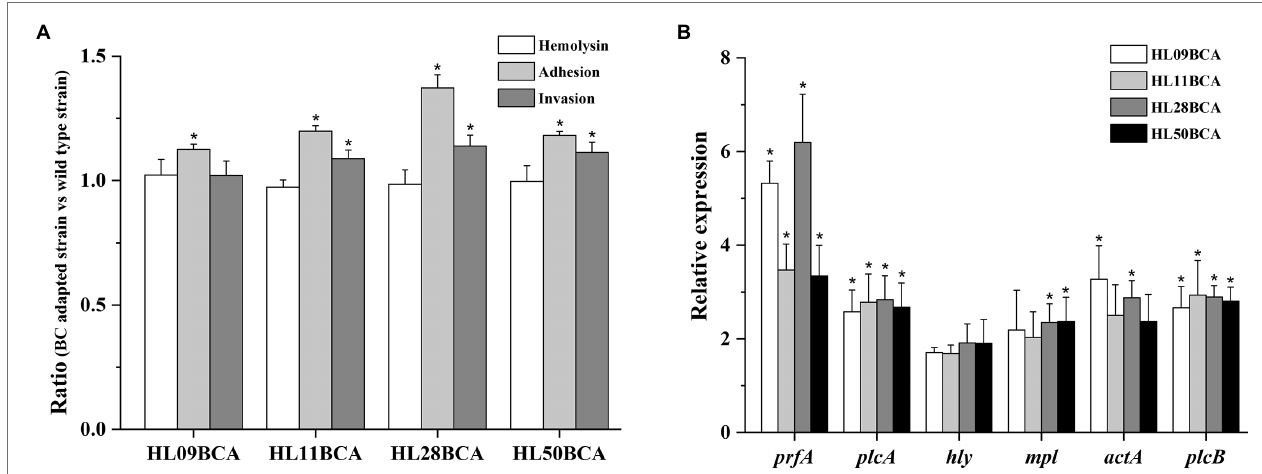
FIGURE 7 | Effect of BC adaptation on (A) hemolysis, Caco-2 adhesion and invasion, and (B) expression of prfA virulence gene cluster. “Ratio” refers to the value of BC adapted strain relative to that of its wild type strain. Error bars indicate standard deviations. The asterisk indicates a value statistically different from that of the wild-type strain, with p <